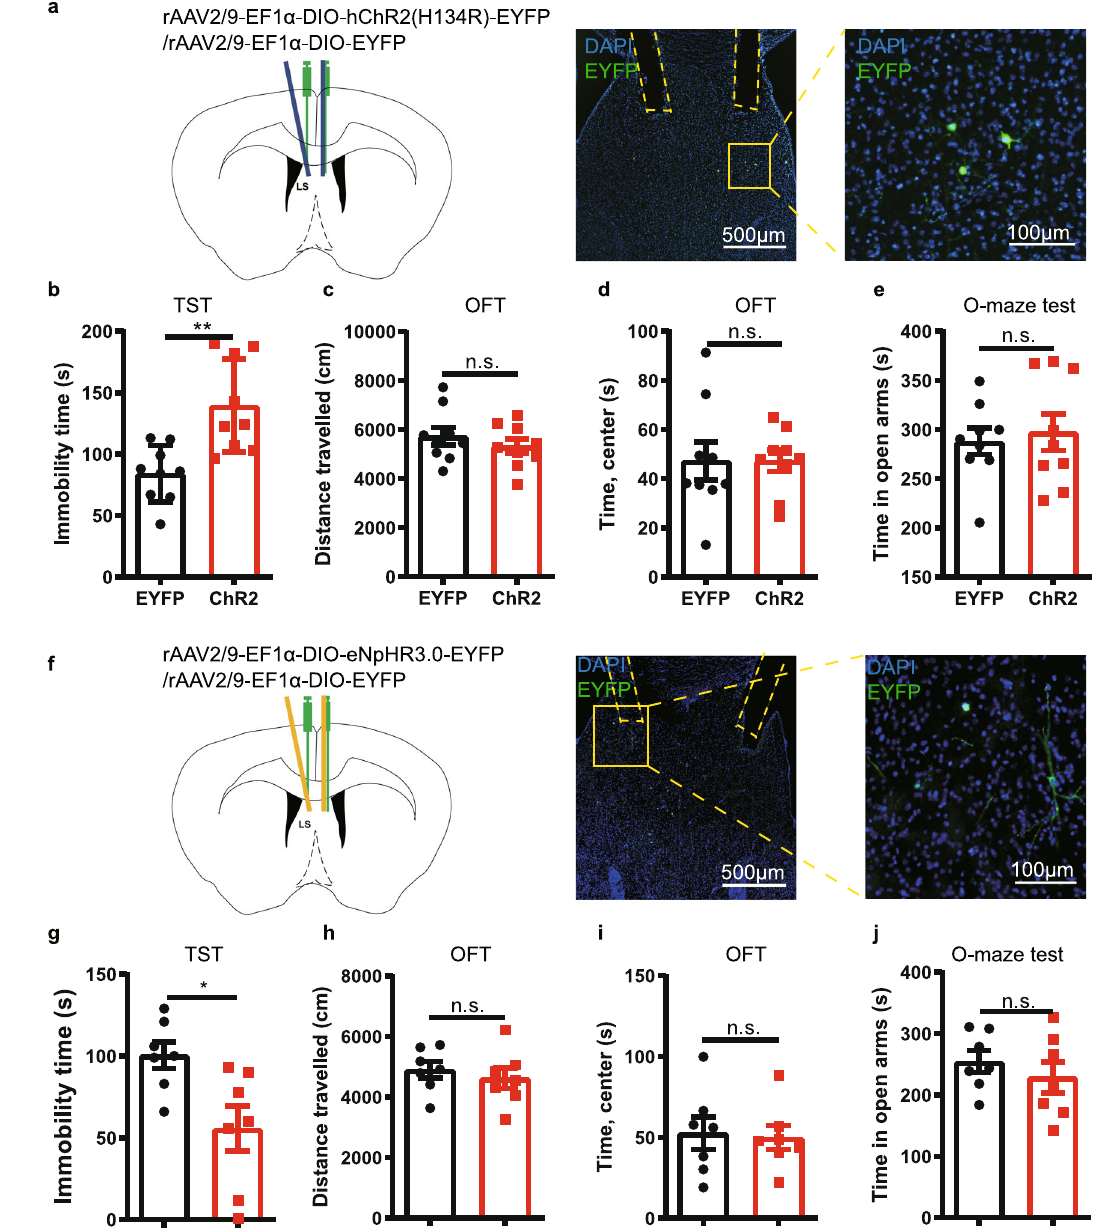
Fig. 4 | Optogenetic modulation of the activity of A 2A R + neurons in the lateral septum (LS) in fl uences depressive-like phenotype. a Left: Schematic illustration of the location of virus injection and optic fi bers implantation in A 2A R-Cre mice. Right: A representative fl uorescent image showing the ChR2-positive neurons (green)andthelocalizationoftheoptic fi bers.NucleiarestainedwithDAPIinblue. Scalebar:500/100 μ m.(b-e)OptogeneticactivationofLS-A 2A R + neuronsincreased the immobility time in the tail suspension test (TST) ( n =9 mice/group, Unpaired t test, p =0.0017, t(16)=3.7710) b without affecting the total distance traveled ( n =9 mice/group, Unpaired t test, p =0.3980, t(16)=0.8684) c or the time in the central area in the open fi eld test (OFT) ( n =9 mice/group, Unpaired t test, p =0.9980, t(16)=0.002512) d and in the elevated O-maze test ( n =9 mice/group, Unpaired t test, p =0.6868, t(16)=0.4106) ( e ). f Left: Schematic illustration of the